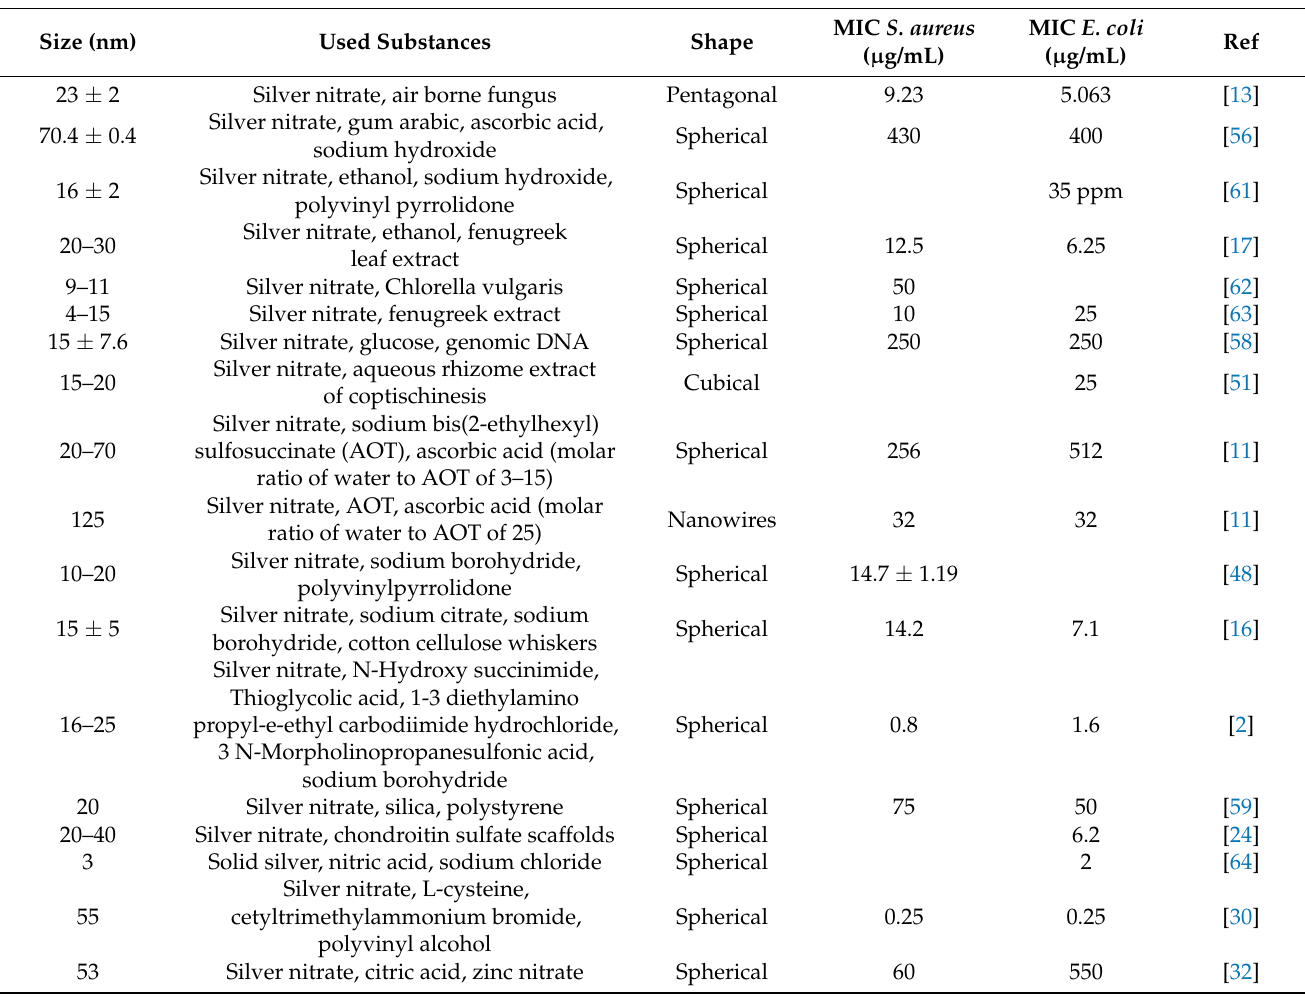
Silver nitrate, citric acid, zinc